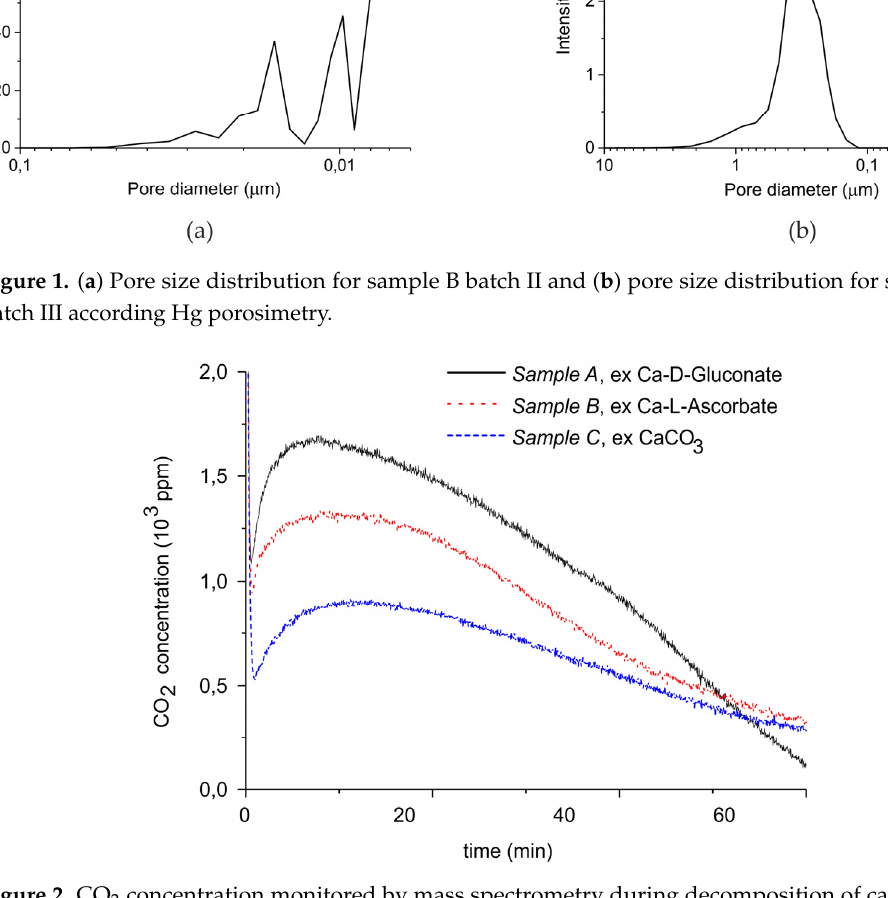
Figure 2. CO 2 concentration monitored by mass spectrometry during decomposition of carbonated sample A (solid line), sample B (dotted line), and sample C (dashed line). The temperature is 630 °C, flow rate is 30 mL min − 1 , and the gas is pure Ar.